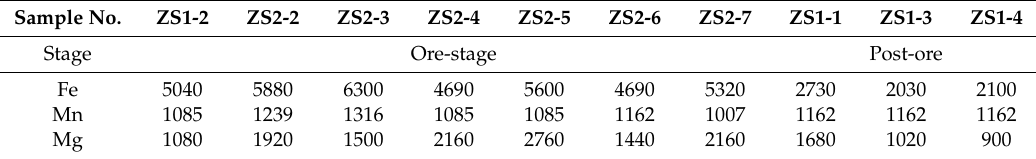
Table 4. Fe, Mn, and Mg contents ( µ g / g, ppm) of calcites from the Zhesang gold deposit. Sample